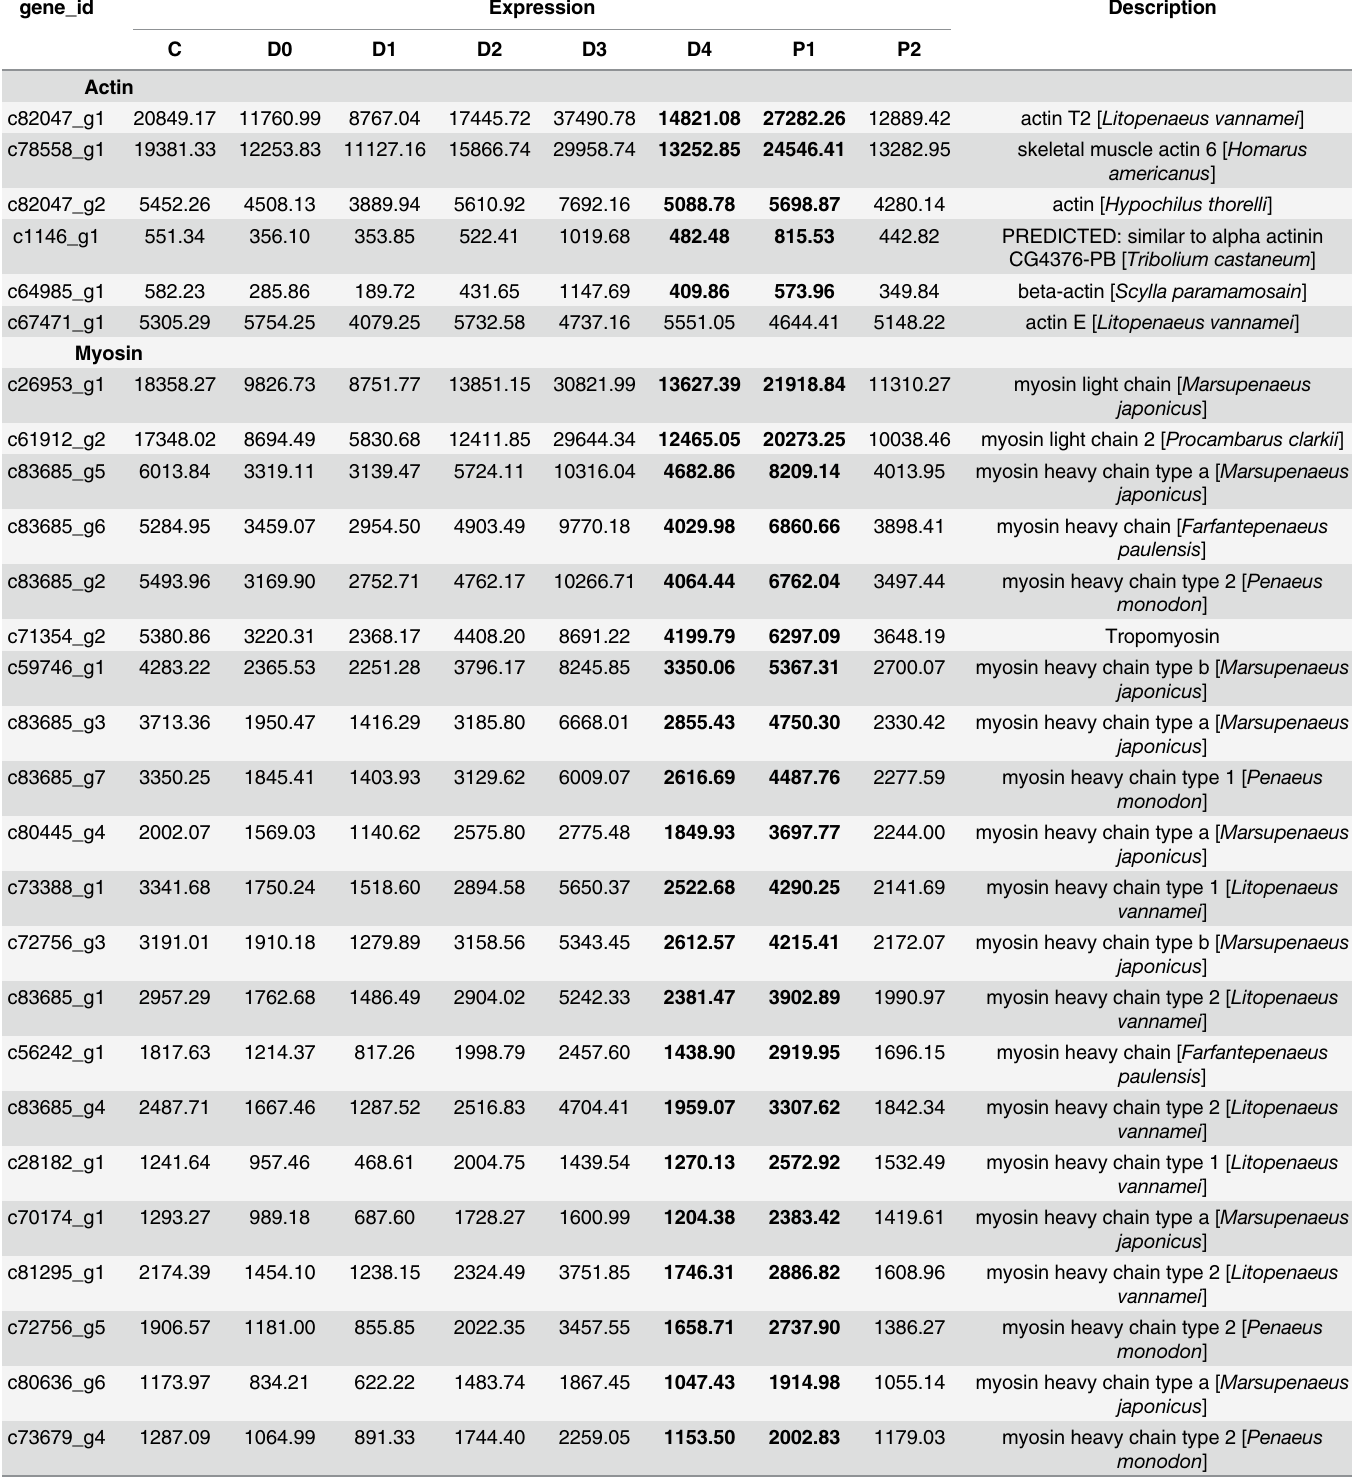
Table 5. Expression levels of actin, myosin and troponin